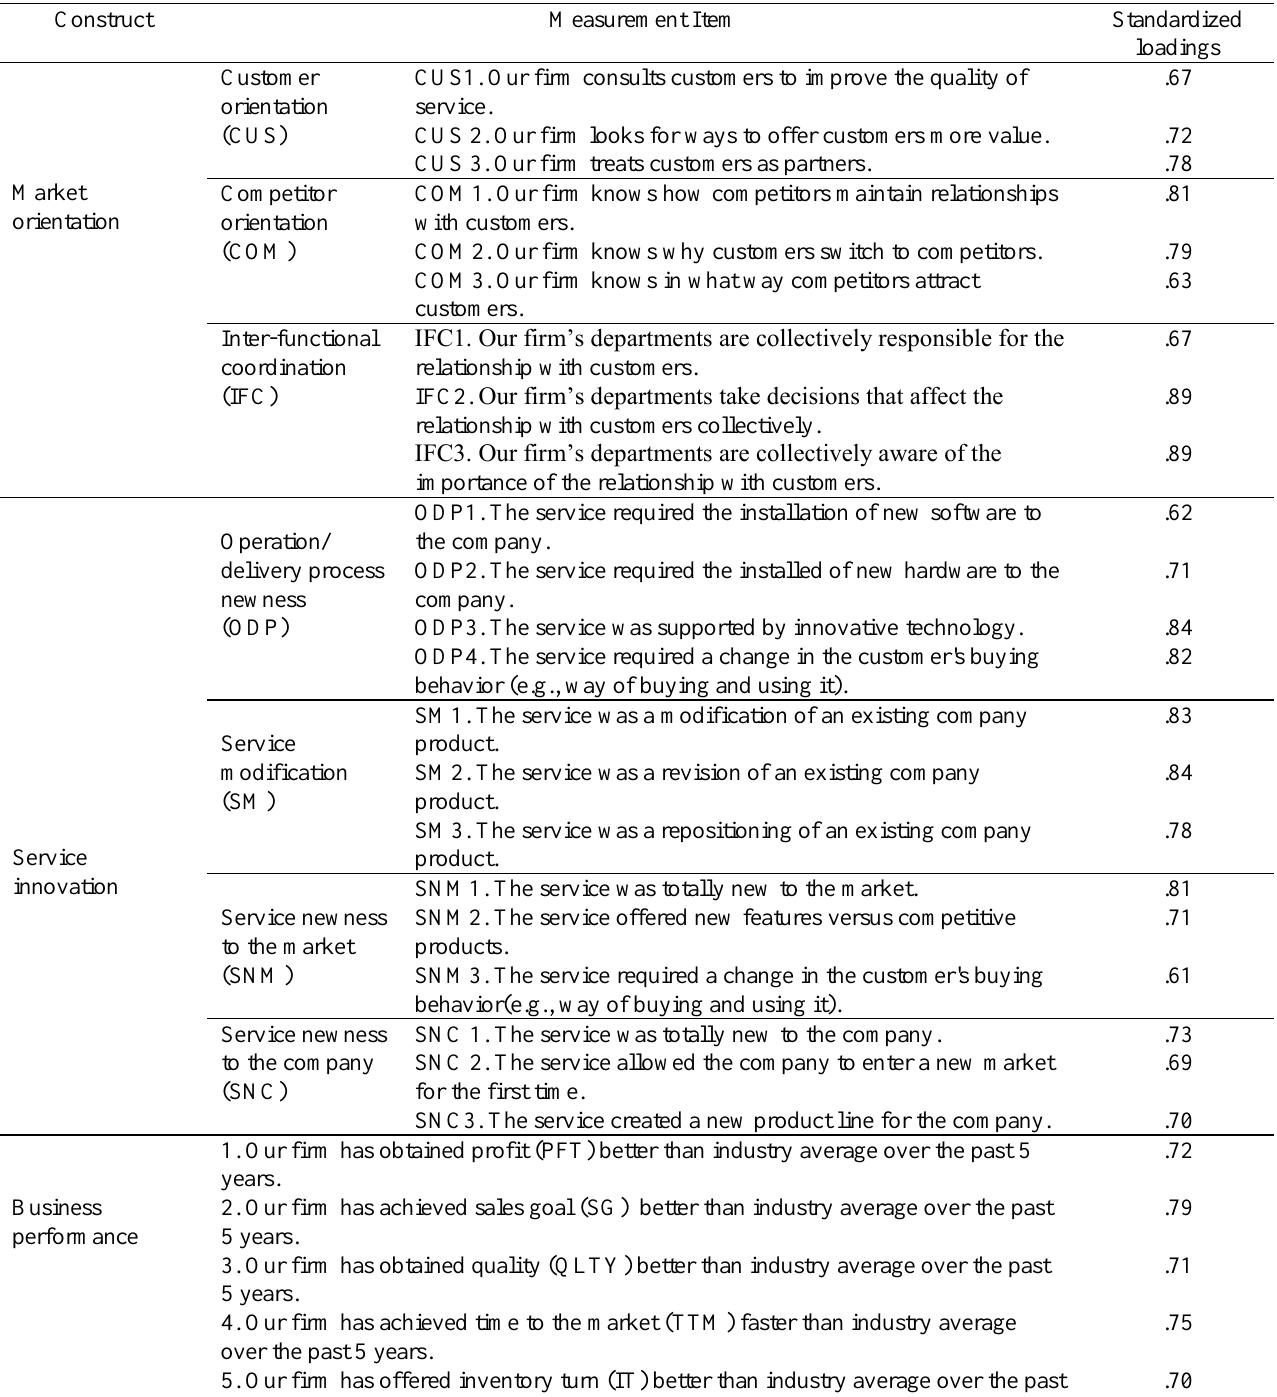
Table 2: Estimates of standardized regression weights